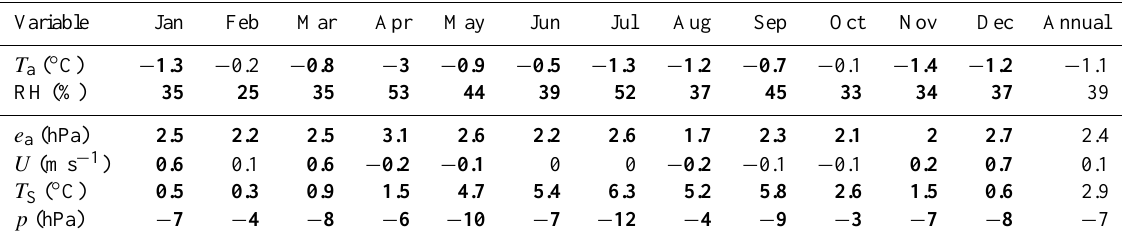
Boldface indicates monthly differences are significant at the 95% level using a two-sided t test assuming unequal variances. Temperature and wind speed are normalized to 2m values.